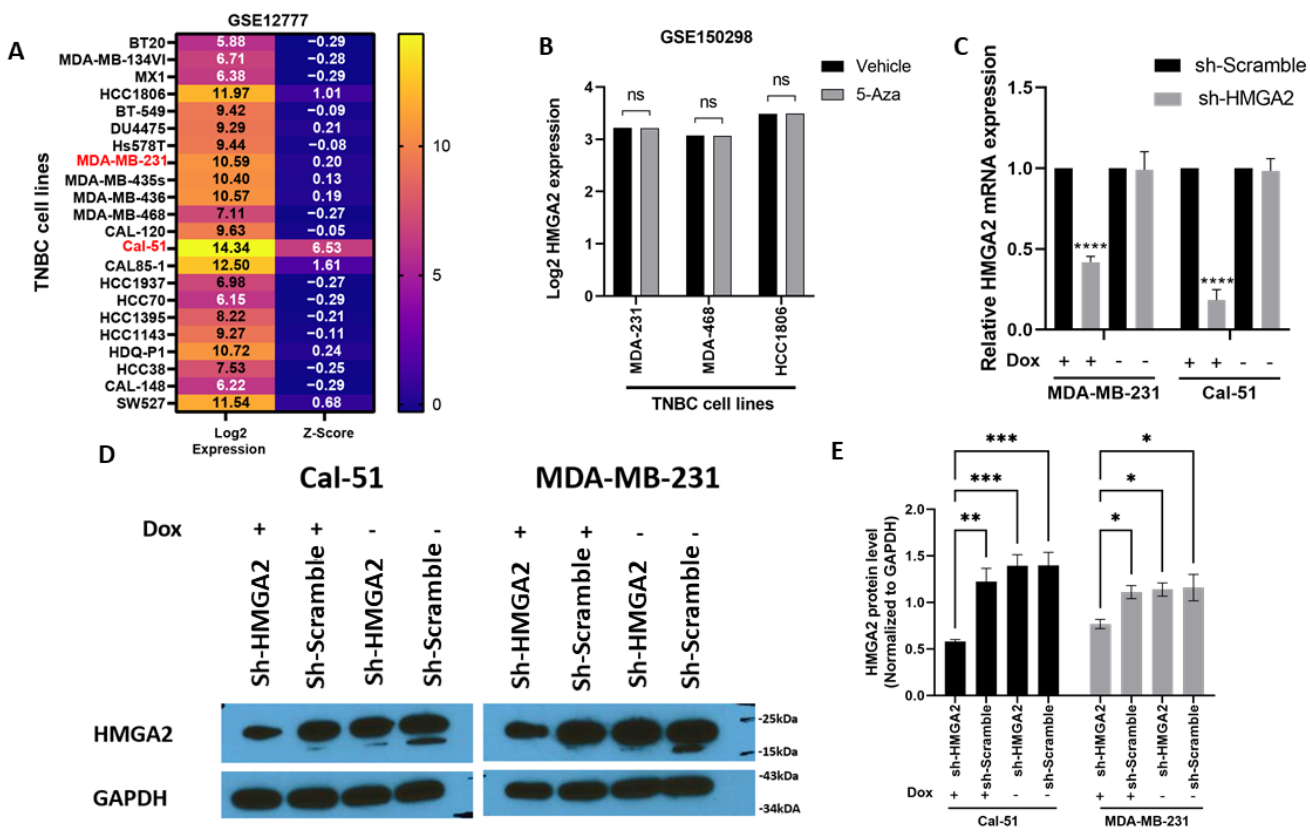
Figure 2. Stable knockdown of HMGA2 expression in TNBC cell lines. HMGA2 mRNA expression level from GSE12777 dataset showing HMGA2 expression in TNBC cell lines ( A ). HMGA2 expression after 5-Azacytidine treatment from dataset GSE150298 did not show changes after treatment in any of MDA-MB-468, MDA-MB-231 and HCC1860 cell lines ( B ). MDA-MB-231 and Cal-51 TNBC cell lines were stably transduced with plasmids encoding a doxycycline-inducible HMGA2 specific shRNA (shHMGA2) or a scrambled shRNA (shScrambled). Treatment of the cells with 1 μg/mL doxycycline (Dox) to induce expression of HMGA2 shRNAs decreased HMGA2 mRNA ( C ) and protein ( D and E ) levels. The results are shown as mean ±SD ( n = 3) of shHMGA2 versus the shScramble group, * p < 0.05, ** p < 0.01, *** p < 0.001, **** p < 0.0001 by t -test.